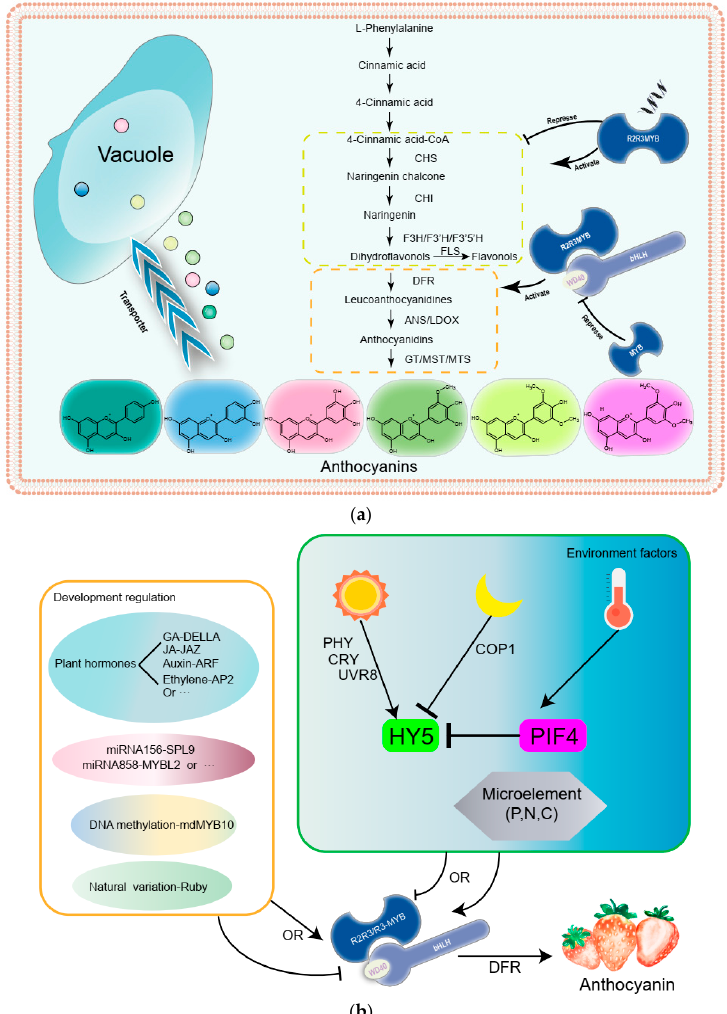
Figure 2. A simplified model of anthocyanin biosynthesis in plants. ( a ) A simplified schematic of the anthocyanin biosynthetic pathway. ( b ) The transcription of anthocyanin biosynthesis genes is regulated by MBW complexes, in which different MYBs enable activate specific parts of the pathway and differentially respond to developmental and environmental cues. MBW: MYB–bHLH–WD40; PAL: phenylalanine ammonia lyase; C4H: cinnamate 4-hydroxylase; 4CL: 4-coumarate-CoA ligase;